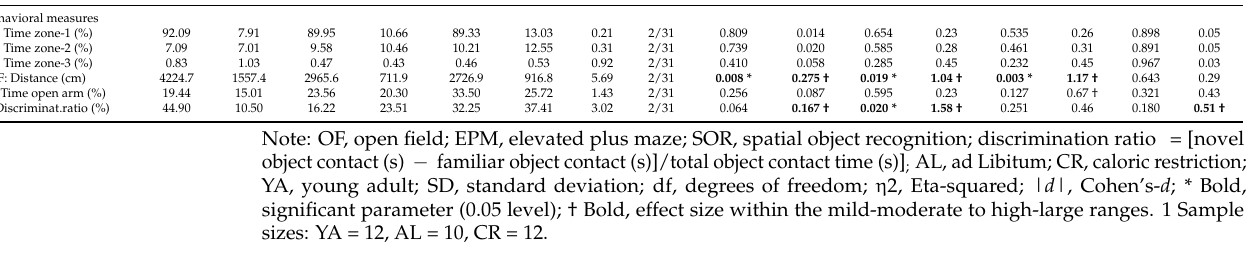
Table 2. Assessment of the immunolabelling data evaluated by one-way